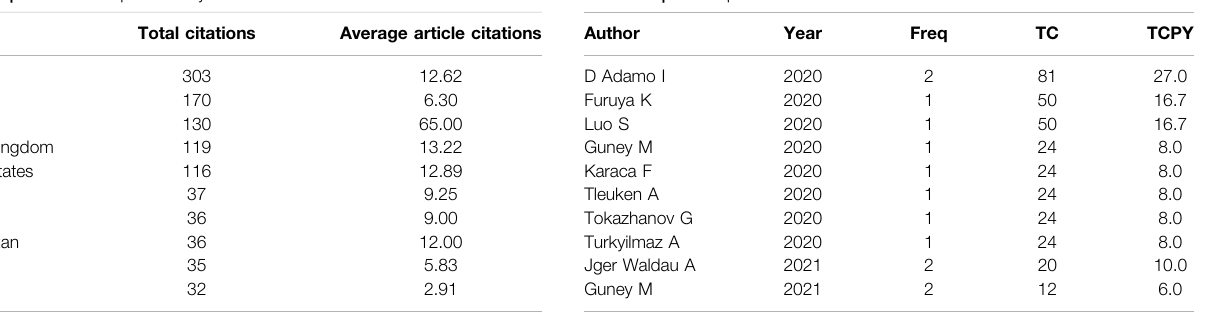
TABLE 8 | Total citation per country. TABLE 9 | Author production and citations